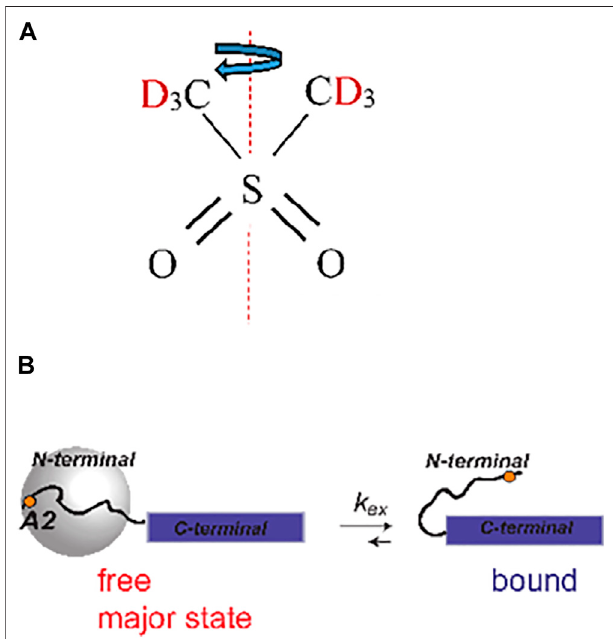
FIGURE 3 | (A) Structure of DMS indicating the 180 ° fl ipping motion aroundtheC 2 axis. (B) Slowtime-scalemotionalmodesoftheA2-CD 3 methyl group of the N-terminal domain of A β 1-40 fi brils (Au et al., 2019). The disordered N-terminal domain (residues 1 – 16, curved line) transiently interacts with the structured C-terminal domain (blue rectangle). In the free state, the N-terminal domain undergoes large-scale diffusive motion, as represented by the gray sphere, which is absent in the bound state. The position of the A2 residue is shown as an orange